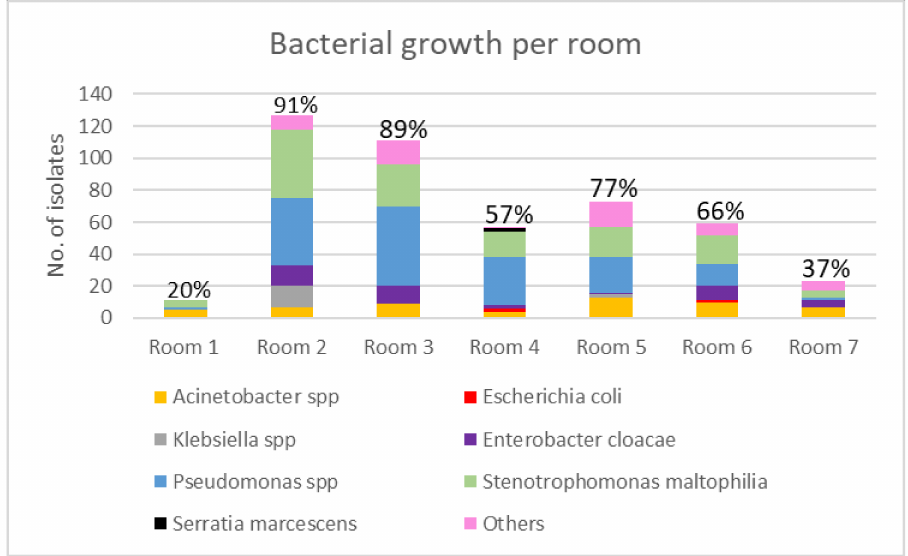
Figure 2. The number of bacterial isolates and types of bacteria are shown per room. The percentages of sampling weeks with bacterial growth are shown above the bar for each room. All rooms had two sinks. The self-disinfecting sinks were installed in room 1, the sinks in room 4 were treated weekly with boiling water, and the sinks in the remaining five rooms were